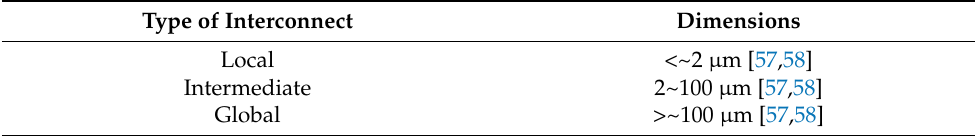
Table 2. Typical values for interconnect size.